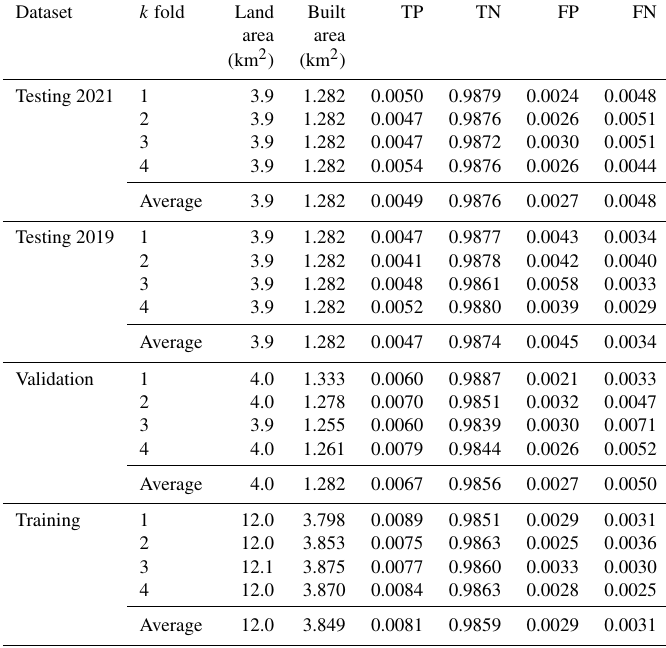
Table A3. Full confusion matrix for the green roof identification method, calculated based on area. TP, TN, FP, and FN are as a proportion of total building footprint area in the hand-labelled areas.